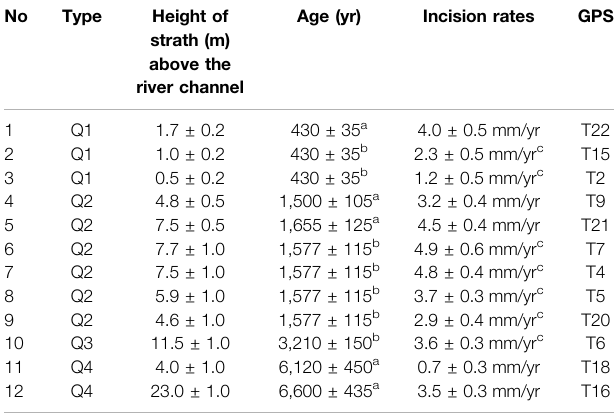
TABLE 3 | Height of strath terraces measured in the fi eld, OSL ages, and derived incision rates.